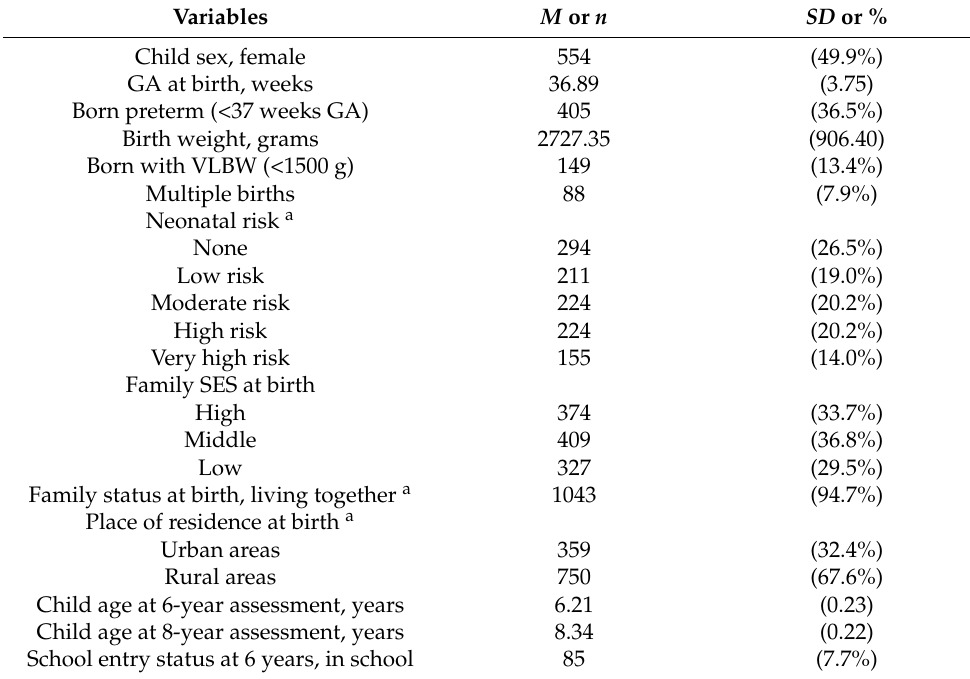
Table 1. Descriptive characteristics of the study sample ( N =